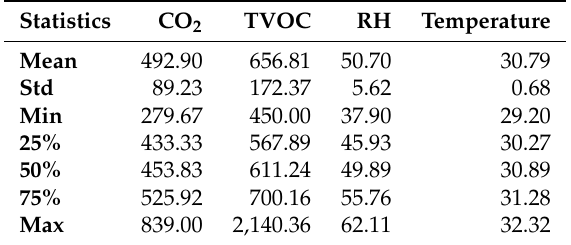
Table 2. Descriptive statistics of the collected IAQ sensor data.